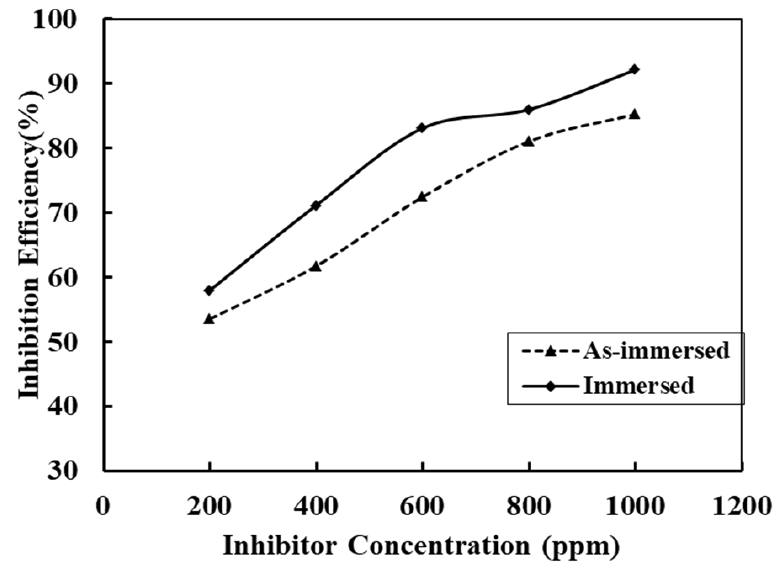
Figure 14. Inhibition efficiency of inhibitor obtained from the polarization of both immersed and as-immersed MS sample 1 M H 2 SO 4 in the presence of AV alkaloid as an inhibitor.